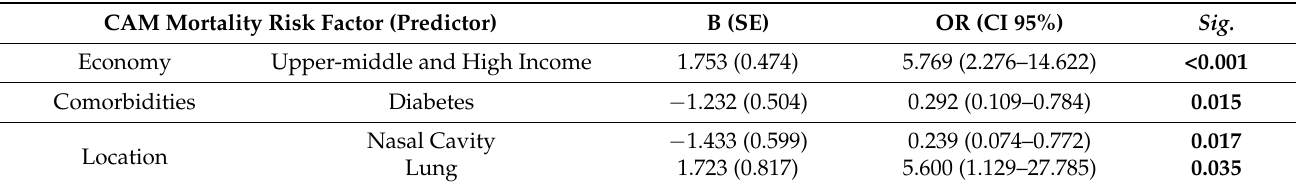
Table 8. Risk Factors of Mortality among COVID-19-associated Mucormycosis (CAM) Cases, Global Evidence Synthesis, January 2020–May 2021. CAM Mortality Risk Factor (Predictor) B (SE)